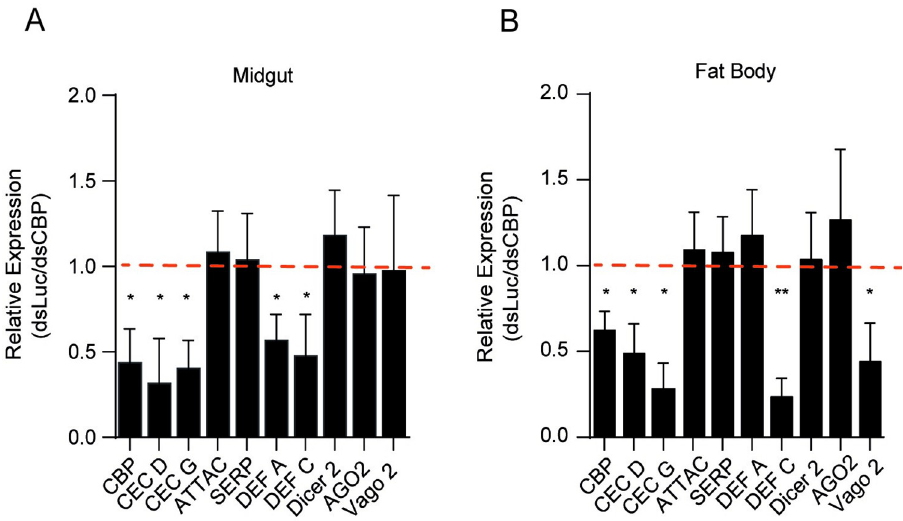
Fig 4. The expression of antiviral immune-response genes is reduced in ZIKV-infected mosquitoes silenced for AaCBP. A and B. Fifty adult female mosquitoes were silenced for AaCBP, and after two days, mosquitoes were infected with ZIKV. The expression of cecropin D (CEC D), cecropin G (CEC G), attacin (ATTAC), serpin (SERP), defensin A (DEF A), defensin C (DEF C), dicer 2 , argonaute 2 (AGO2) and vago 2 in the midgut (A) or fat body (B) was measured by qRT-PCR four days post infection. Silencing levels of AaCBP in both tissues are shown (first bars in Panels A and B). qRT-PCR was performed from 3 independent biological replicates. Bars indicate the standard error of the mean; statistical analyses were performed by Student’s t test. � , p <